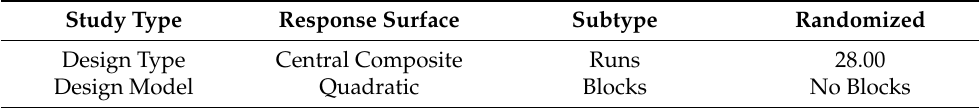
Table 7. ANOVA design matrix.